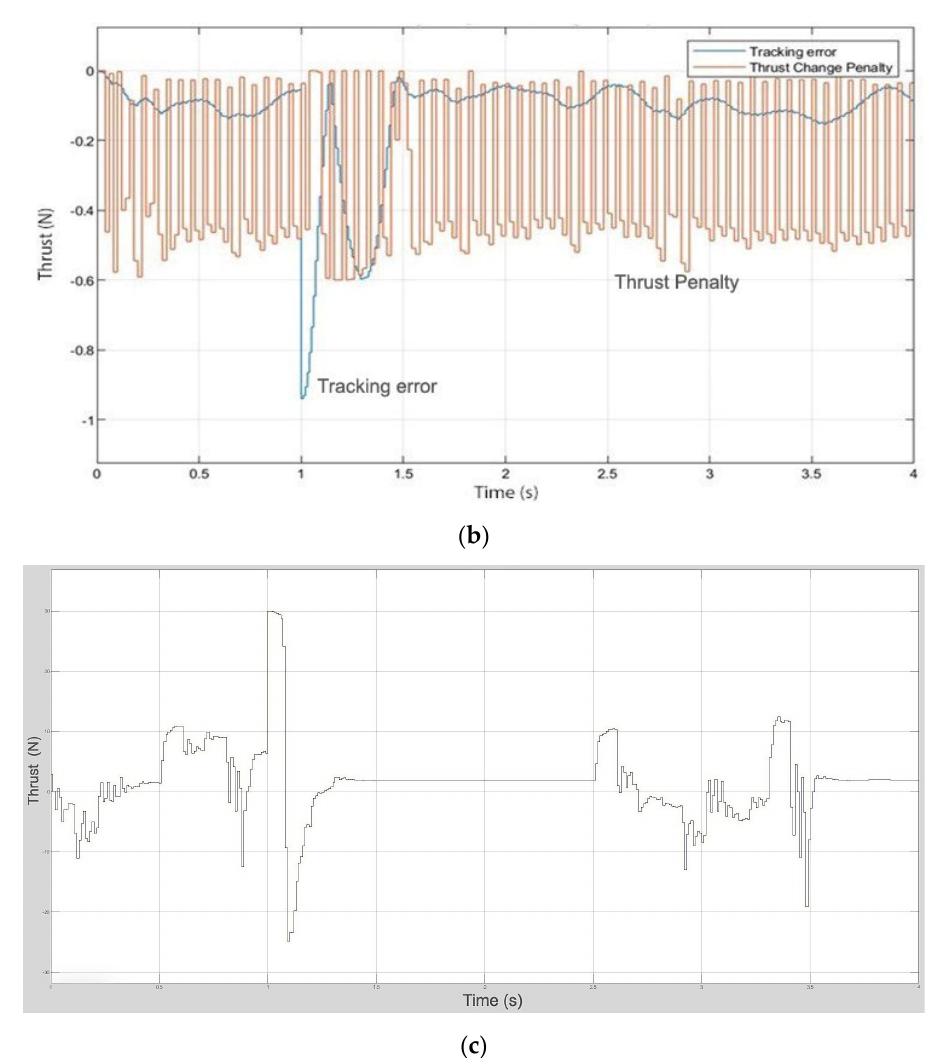
Figure 16. ( a ) Adjust the height of the Drone to follow the set signal. ( b ) The actual change of the drone system. ( c ) Change of the rudder so that the error deviates from the trajectory to zero.